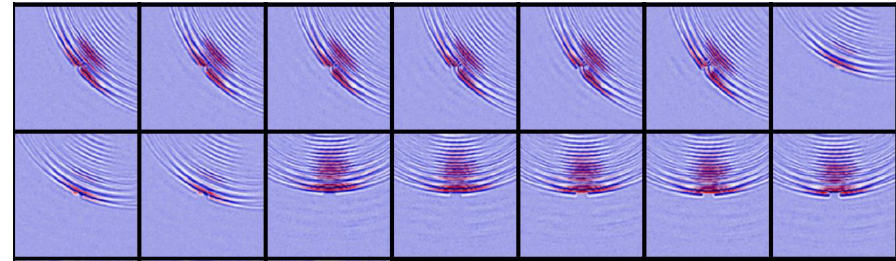
Figure 10. Sample images of misclassification.